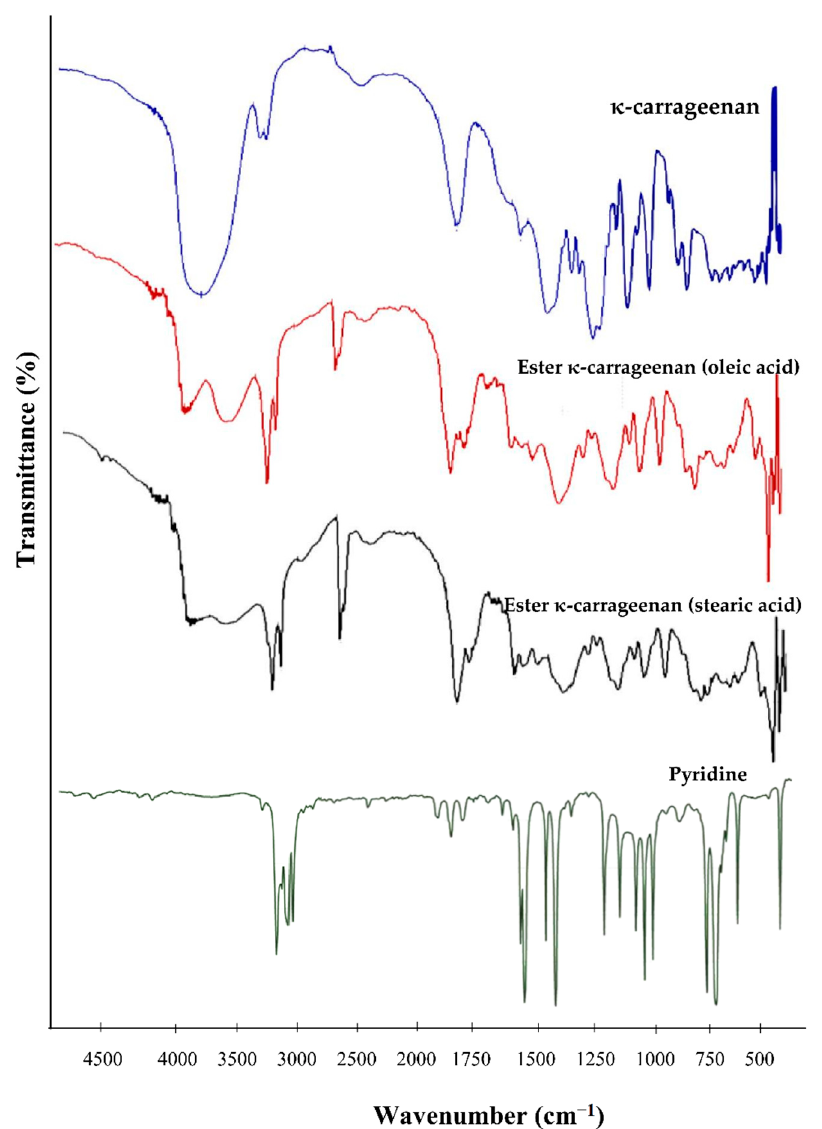
Figure 1. FTIR spectra of pyridine, κ -carrageenan, and its ester derivatives.